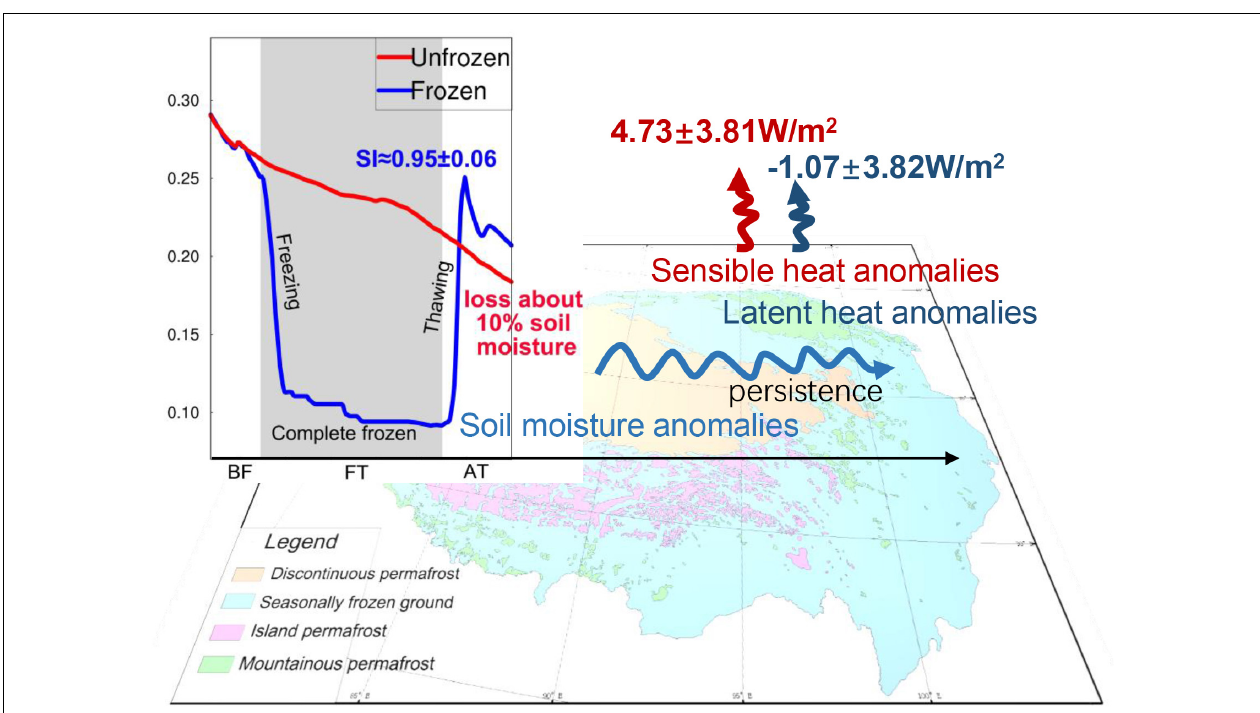
FIGURE 2 | Schematic diagram summarizing the impacts of soil freeze–thaw (FT) process on surface diabatic heating over Tibetan Plateau (TP). This diagram illustrates that soil moisture varies before freeze, FT, and after thaw (AT) periods, soil FT process has a water storage effect, and the storage index (SI) can reach 0.95 ± 0.06 at surface soil layer. Without the soil frozen process, the loss of soil moisture during AT period would be 10%, which further leads to anomalies of surface sensible heat by 4.73 ± 3.81 W/m 2 and anomalies of surface latent heat by –1.07 ± 3.82 W/m 2 through persistent soil moisture anomalies (Yang and Wang, 2019b). The map of the frozen soil over TP, including permafrost and seasonally frozen ground, comes from Li and Cheng (1996).